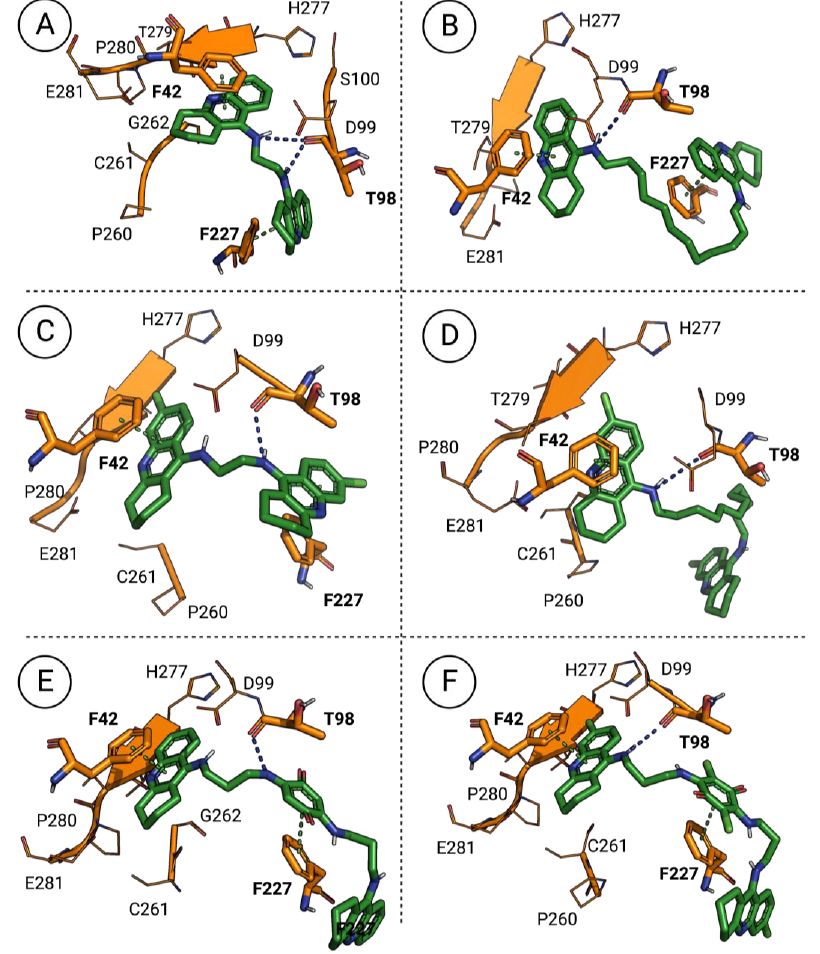
Figure 4. Docking poses of the 1,2,3,4-tetrahydroacridine dimers in the AdoMet DC’s catalytic site: ( A ) docking pose of 10.a ; ( B ) docking pose of 10.g ; ( C ) docking pose of 10.h ; ( D ) docking pose of 10.n ; ( E ) docking pose of 9.a ; ( F ) docking pose of 9.d . Blue dashed lines correspond to hydrogen bonds and green dashed lines correspond to π – π interactions